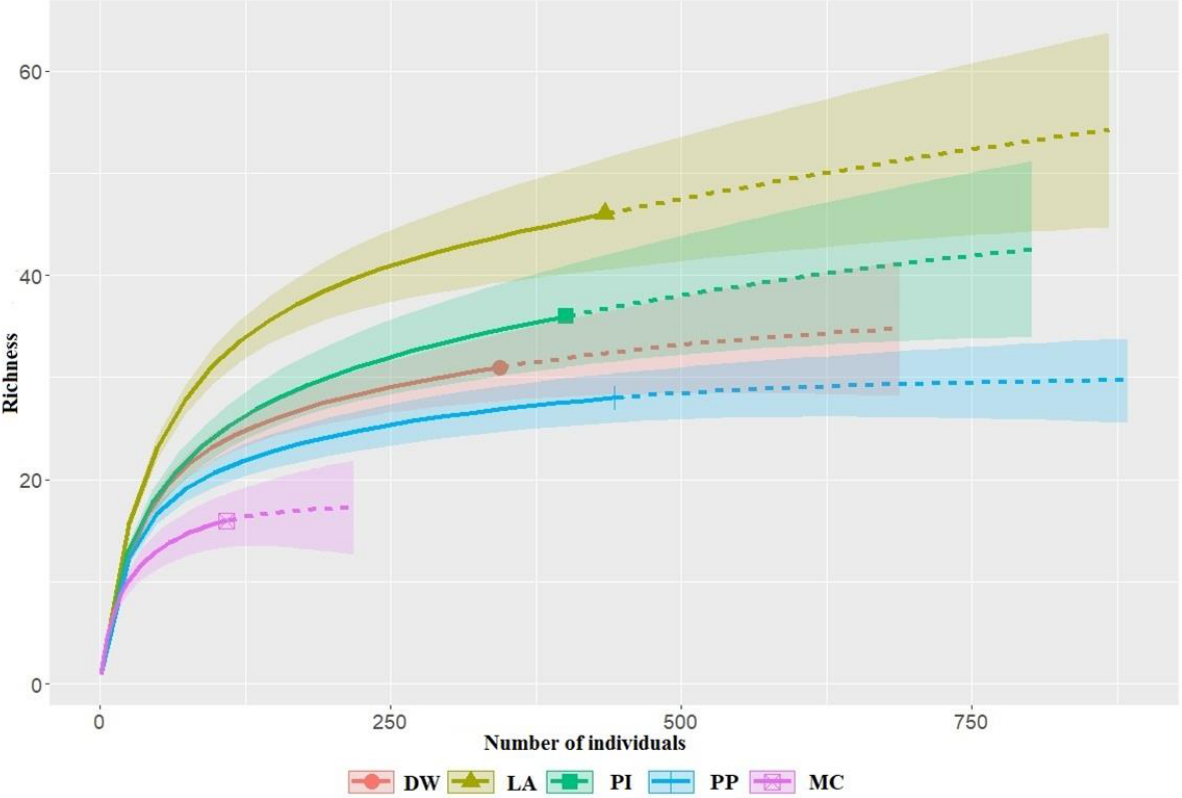
Figure 2. Species richness of birds was recorded during this survey in the Khentii Mountains. Habitat variables are deciduous woodland (DW), larch (LA), pine (PI), pine plantation (PP), and mixed conifer (MC). Solid and dashed lines are interpolated and extrapolated data, respectively, based on rarefaction and extrapolation methods, with their associated 95% confidence intervals.